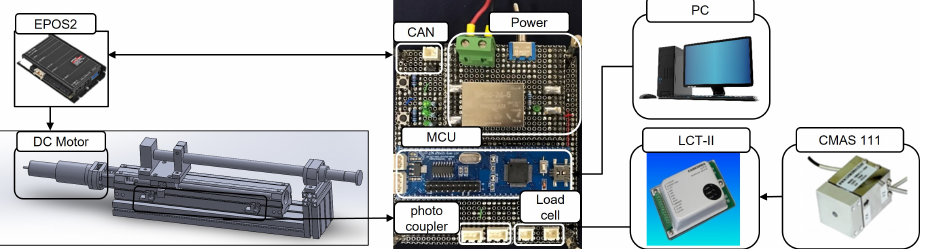
Figure 13. Configuration of elasticity measuring